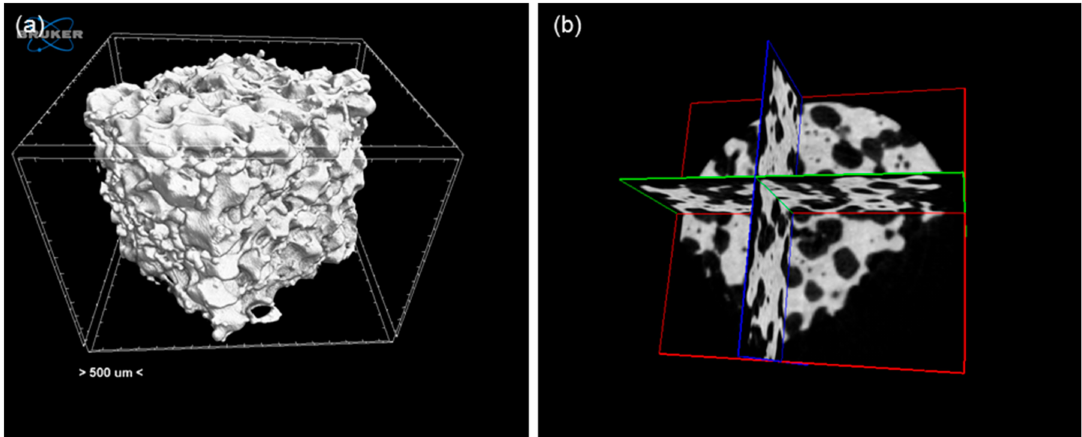
Figure 4. Exemplary micro-CT analysis of the Cu-doped scaffolds: ( a ) 3D reconstruction of the scaffold volume and ( b ) cross-sections in the [xy], [xz] and [yz] orthogonal